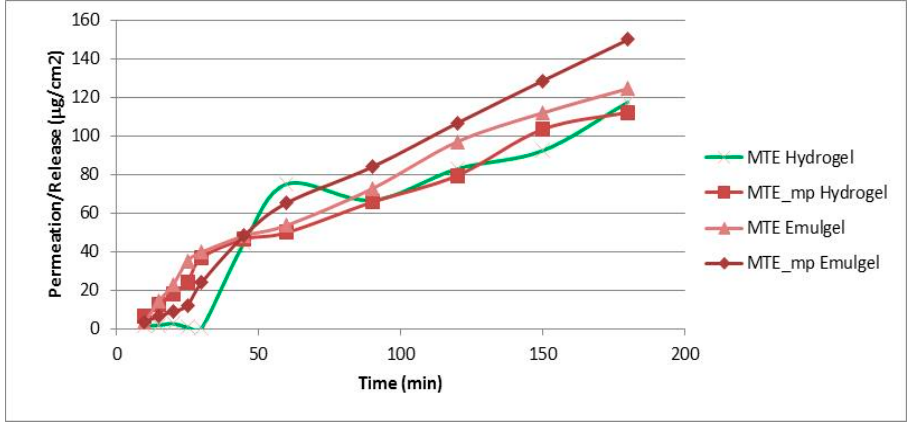
Figure 4. In vitro permeation release study through Franz Cells of all produced formulations (standard deviation for each point < 1%).